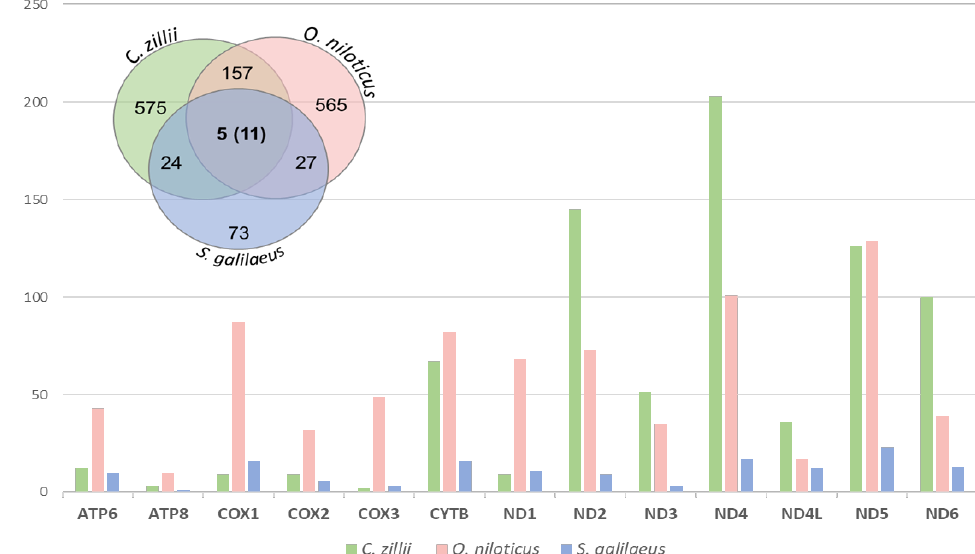
Figure 2. A comparative Vann diagram between three species of Nile tilapiine based on the number of SNPs annotated in CDS. The numbers exclusive to each circle show the number of SNPs that are polymorphic within one species and the number in the overlap area is that of the polymorphic sites shared between species. The distribution of the number of SNPs per CDS gene among the Nile tilapiine mitogenomes that represents in the clustered column chart. The light green color represents C. zillii species, the rose color represents O. niloticus , and the light blue color represents S. galilaeus .